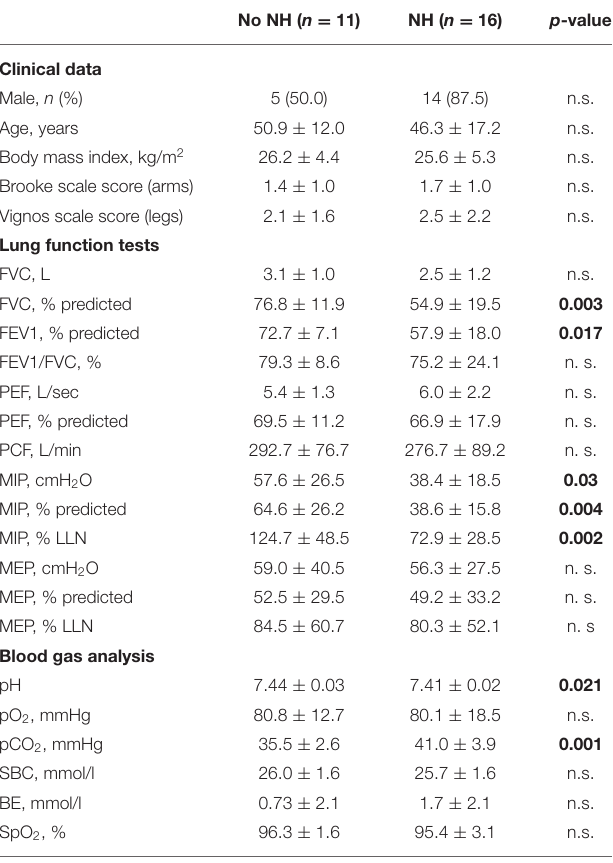
TABLE 1 | Demographic, clinical, basic lung function data and blood gas analysis in patients with and without nocturnal